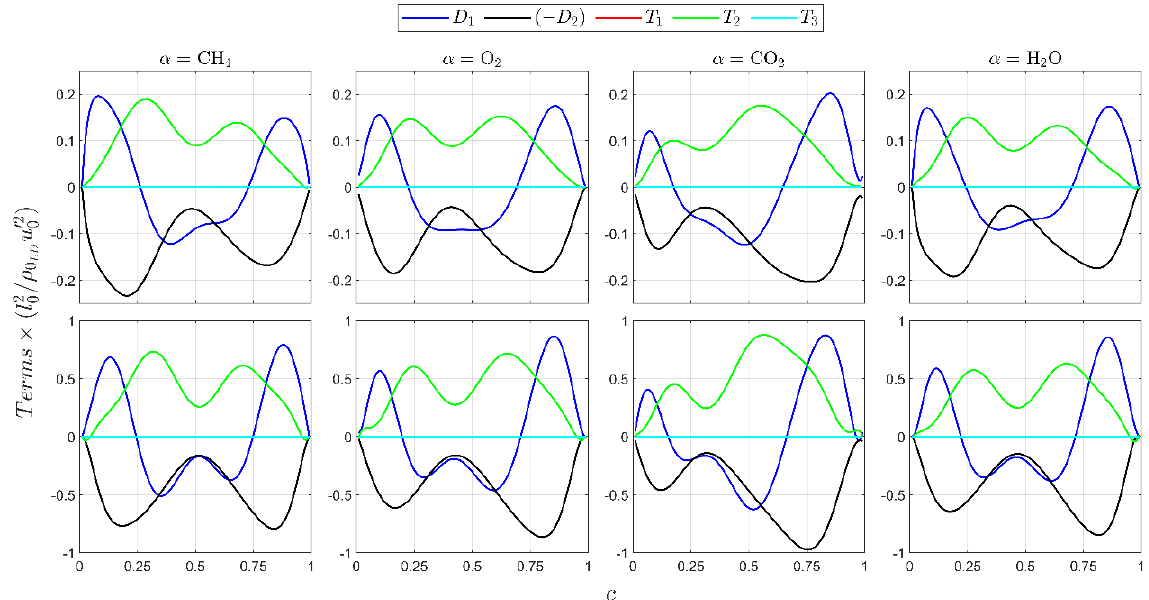
Figure 8. Profiles of the mean contributions of the terms on the right-hand side of the SDR transport equation (i.e., {𝐷 1 , 𝑇 1 , 𝑇 2 , 𝑇 3 , −𝐷 2 } × 𝑙 02 /𝜌 0 𝑢 0′ 2 ) conditioned upon 𝑐 for different definitions of reac- tion progress variable 𝑐 for passive scalar mixing cases with initial 𝑢 ′ /𝑆 𝐿 = 4.0 (1 st row) and 8.0 (2 nd row).